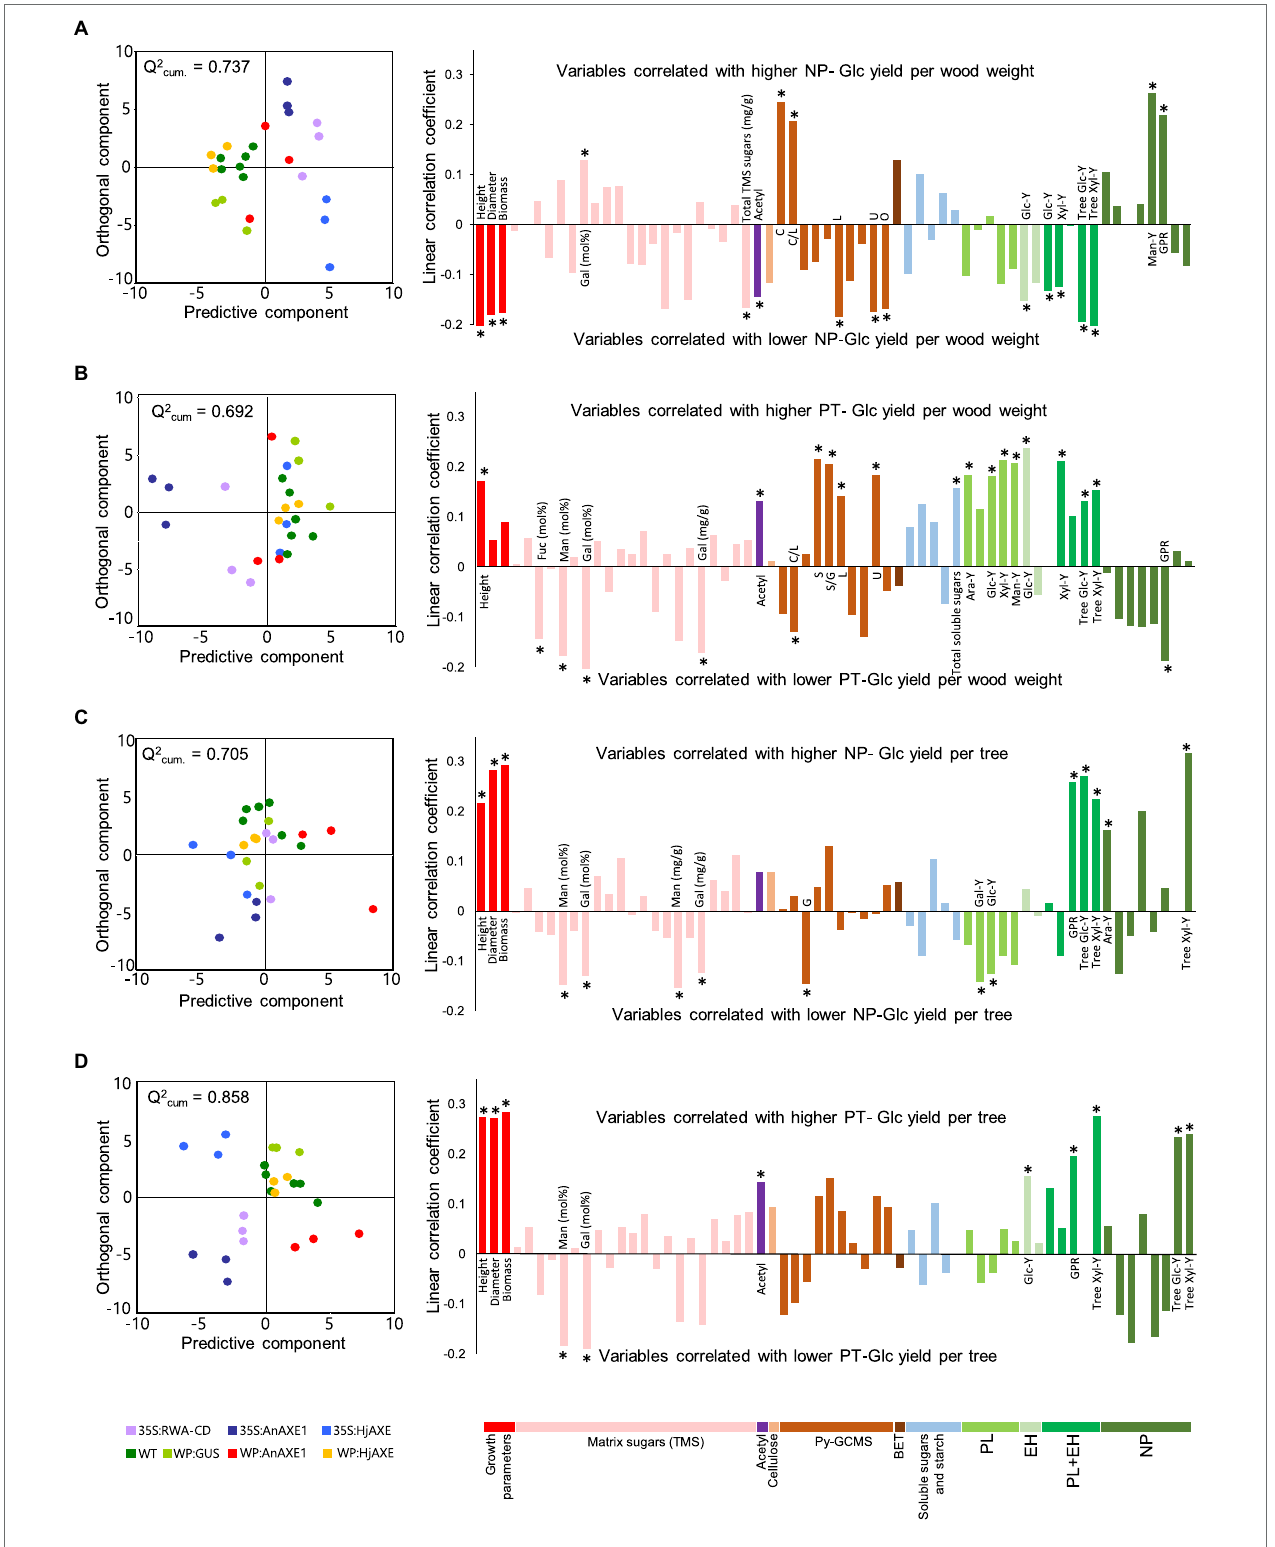
FIGURE 8 | Contributions of indicated variables to predicted glucose yield in saccharification. Modeled contributions to: (A) glucose yield per unit wood weight in saccharification without pretreatment (NP), (B) glucose yield per unit wood weight in saccharification with acid pretreatment (PT), (C) “tree glucose yield” in NP,